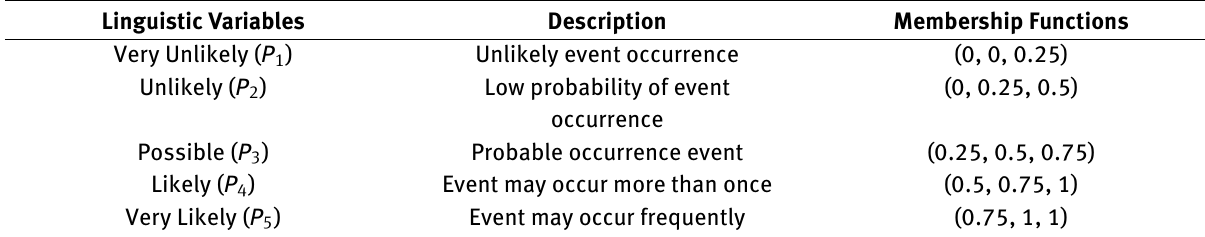
Figure 3: Structure of the Fuzzy Inference System for level 1. Table 1: Linguistic variables for the probability ( p ) and membership